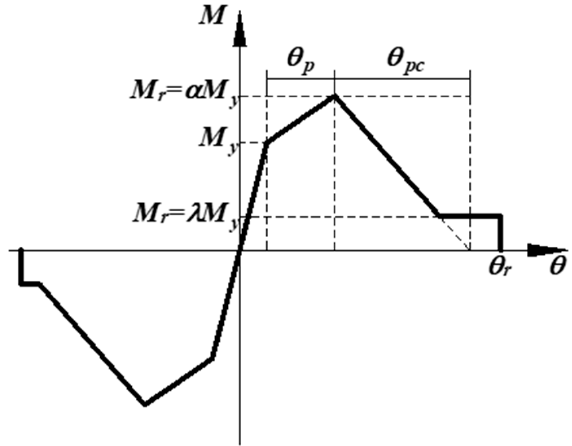
Figure 4. Skeleton curve of the IMK model.